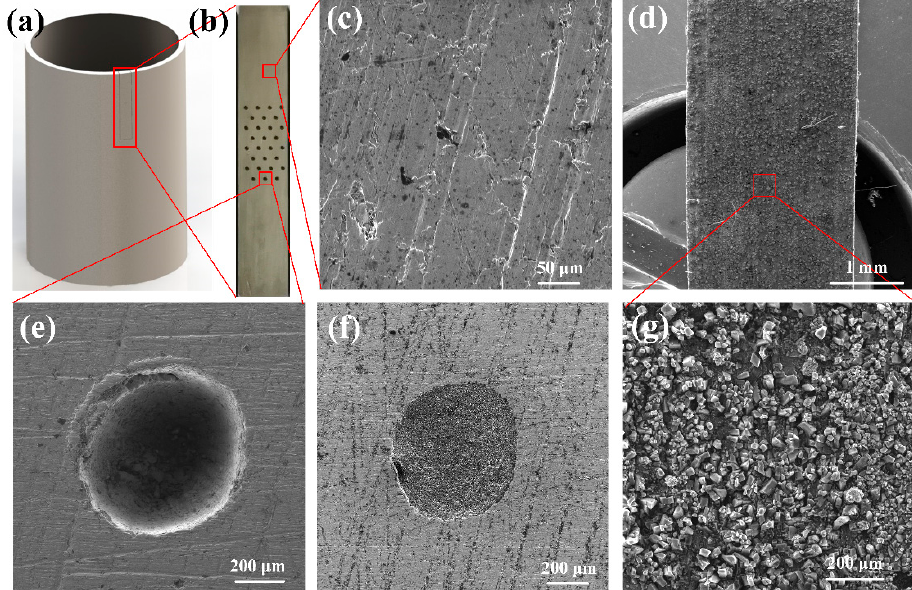
Figure 1. The schematic of the prepared cylinder samples: ( a , b ) the schematic of the cylinder cutting process, ( c ) the morphology of the surface of original cylinder, ( d , g ) the morphology of surface of the piston ring, ( e ) the morphology of the dimple before filling WS 2 , ( f ) the morphology of dimple after filling WS 2 .